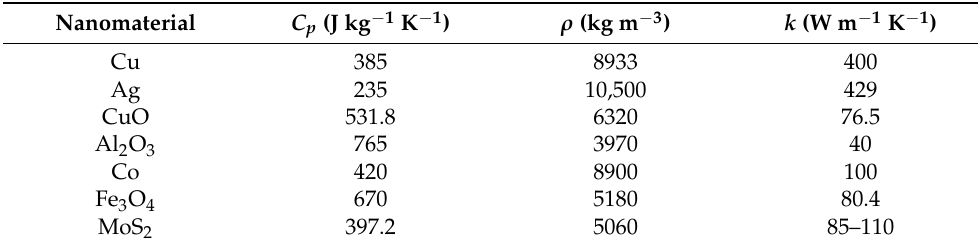
Table 1. Thermophysical properties of widely used nano-additives